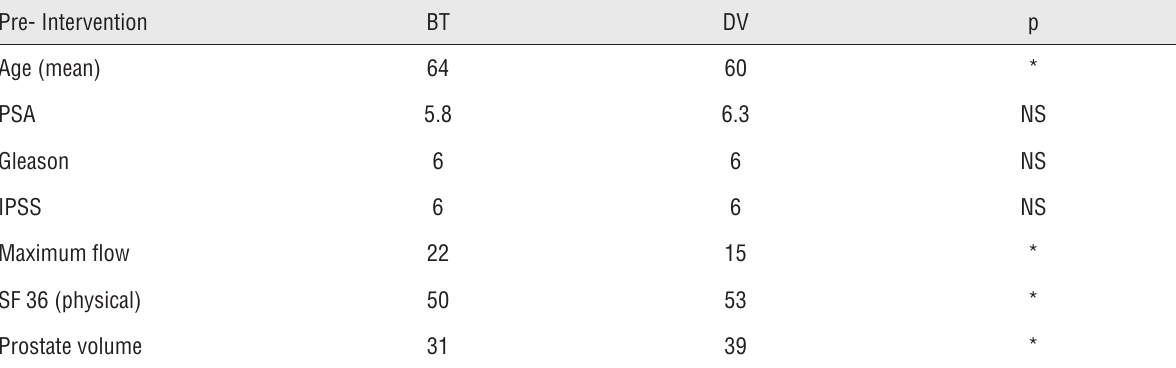
Table 1 - Pre-treatment description of age, PSA level, Gleason score, IPSS, maximum flow and SF36 in the two groups of patients. Pre- Intervention